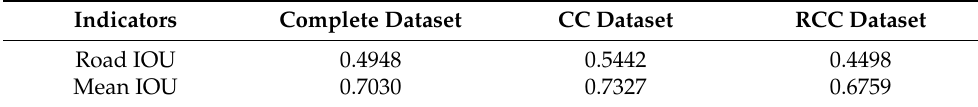
Table 1. Applying CCA module to different